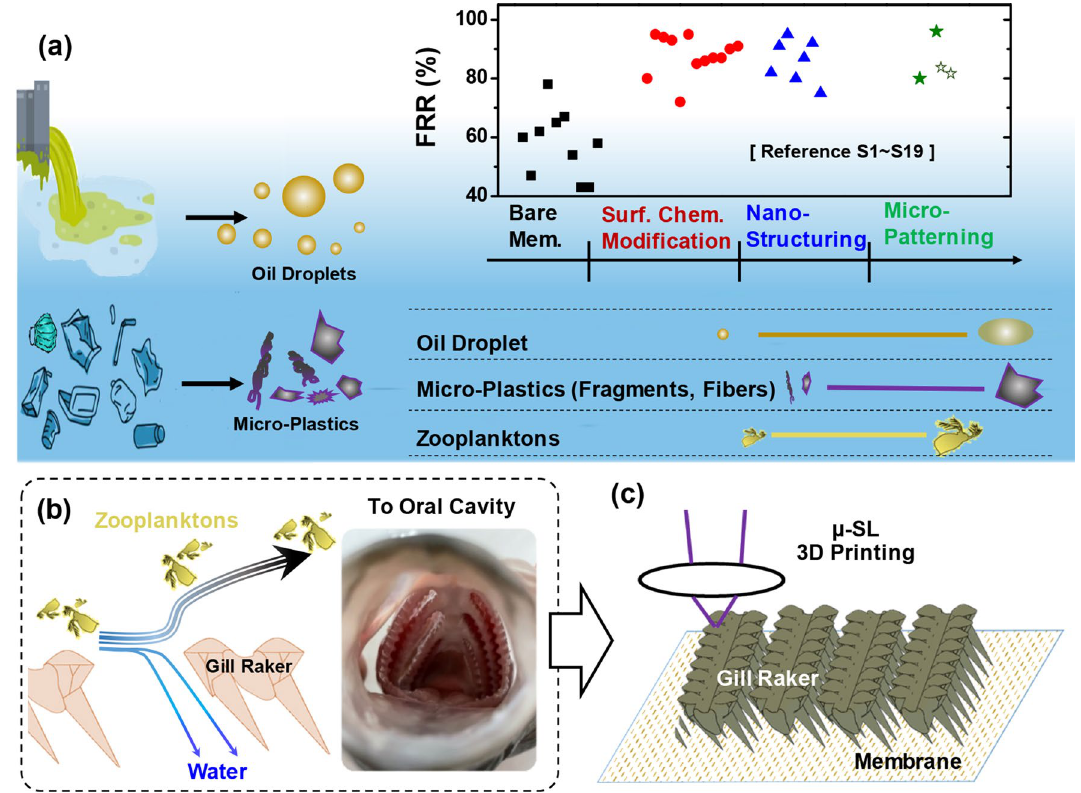
Figure 1. Bio-inspired anti-fouling membrane filtration device enabled by 3D printing-on-membrane. ( a ) Membrane filtration for wastewater treatment. The flux recovery ratio (FRR) for existing anti-fouling/clogging strategies are summarized from reported literatures (also see Table S1 of Supporting Information), including surface chemistry modification, nano-structuring, and micro-patterning. The sizes of oil droplet in produced water, micro-plastics found in marine environment, and food particles from fish gut content analysis. ( b ) Illustration of fish filtering food particles out of water via hydrodynamic manipulation and the optical image of fish mouth with gill raker structures. ( c ) Fish-mimicked anti-fouling membrane filtration device enabled by 3D printing on membrane. The gill-shaped structures are directly printed on membrane surface for anti-fouling filtration by using micro-stereolithography 3D printing